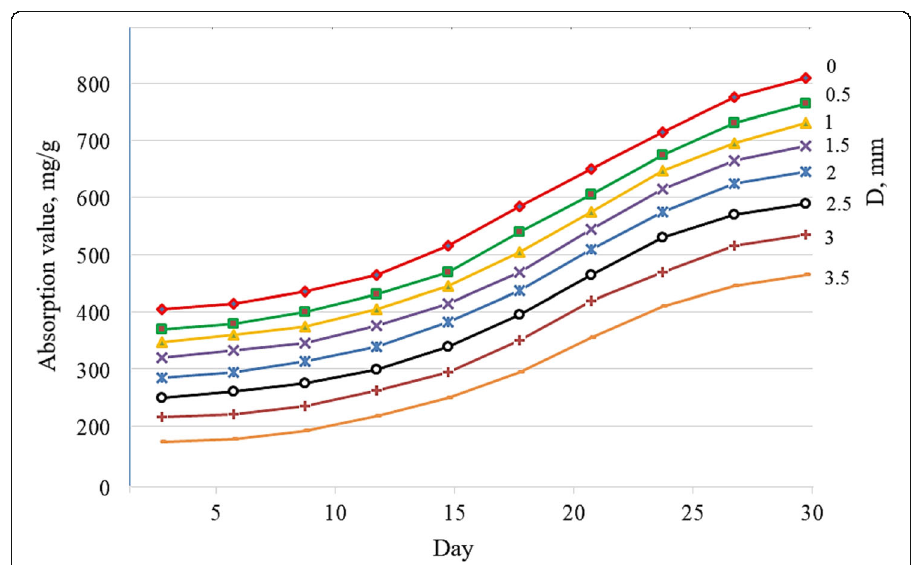
Fig. 6 Hydraulic activity of GPIS granules for absorption of lime depending on the size of particle — D, millimeter and the length of hydration in